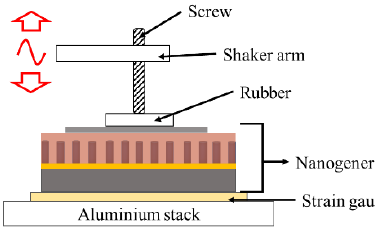
Figure 4. Measurement test bench for PENG performances.